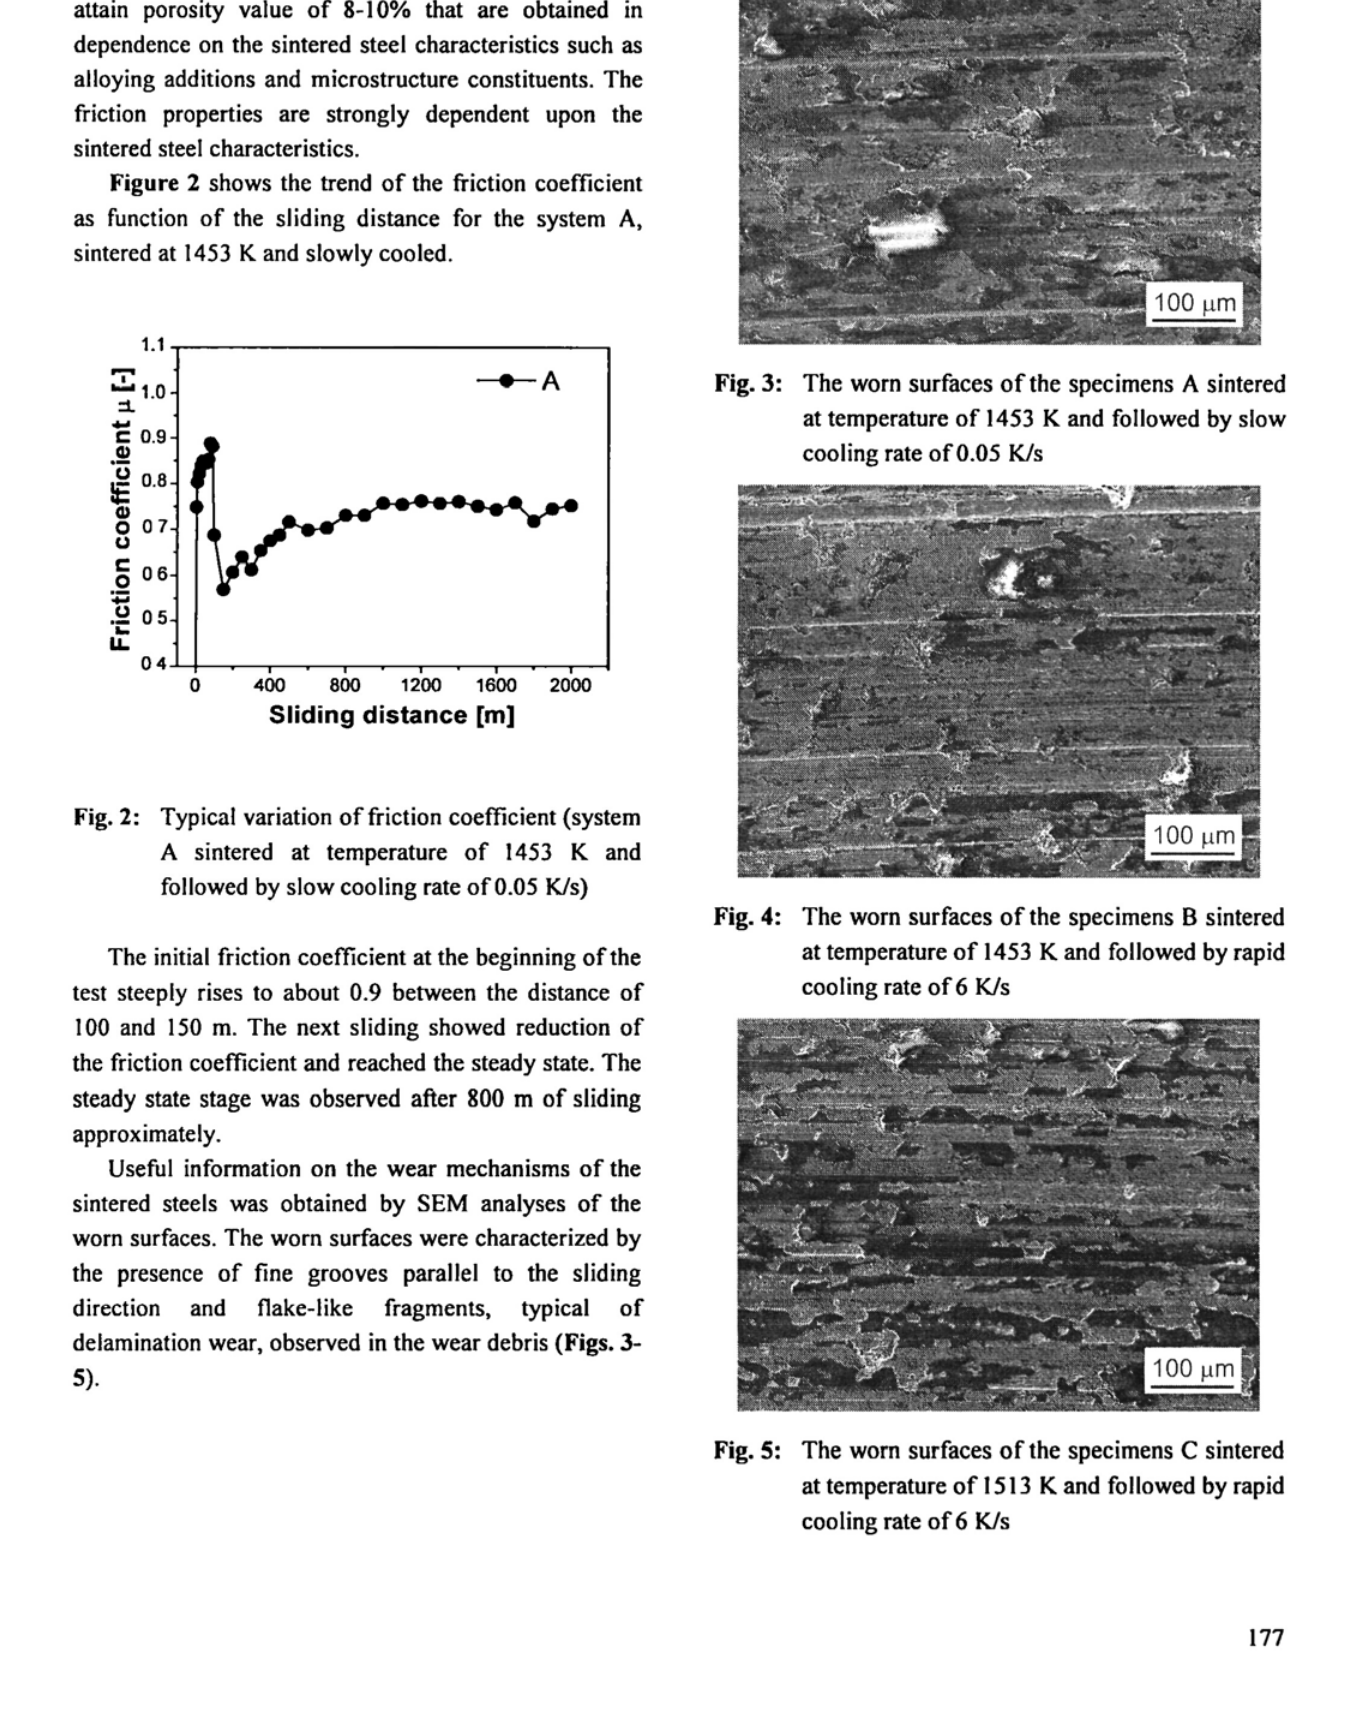
Fig. 3: The worn surfaces of the specimens A sintered at temperature of 1453 K and followed by slow cooling rate of 0.05 K/s